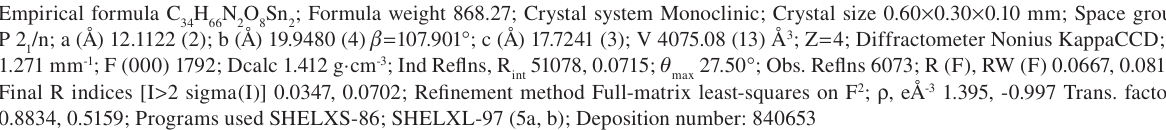
Table 1 Crystal data and structure refi nement.